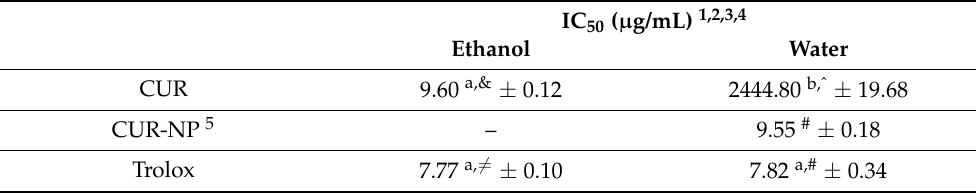
Table 2. Antioxidant activity of free CUR, CUR-NP and